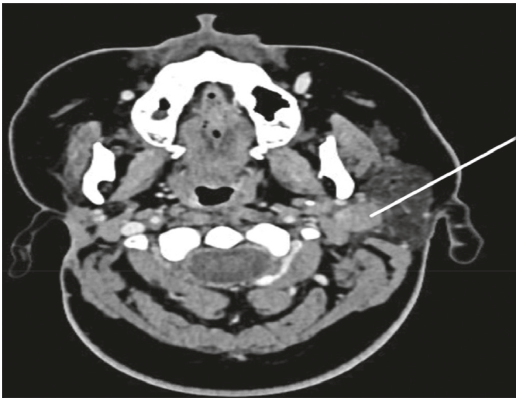
Figure 5: The CT scan showing a left deep parotid gland lesion in 2020.